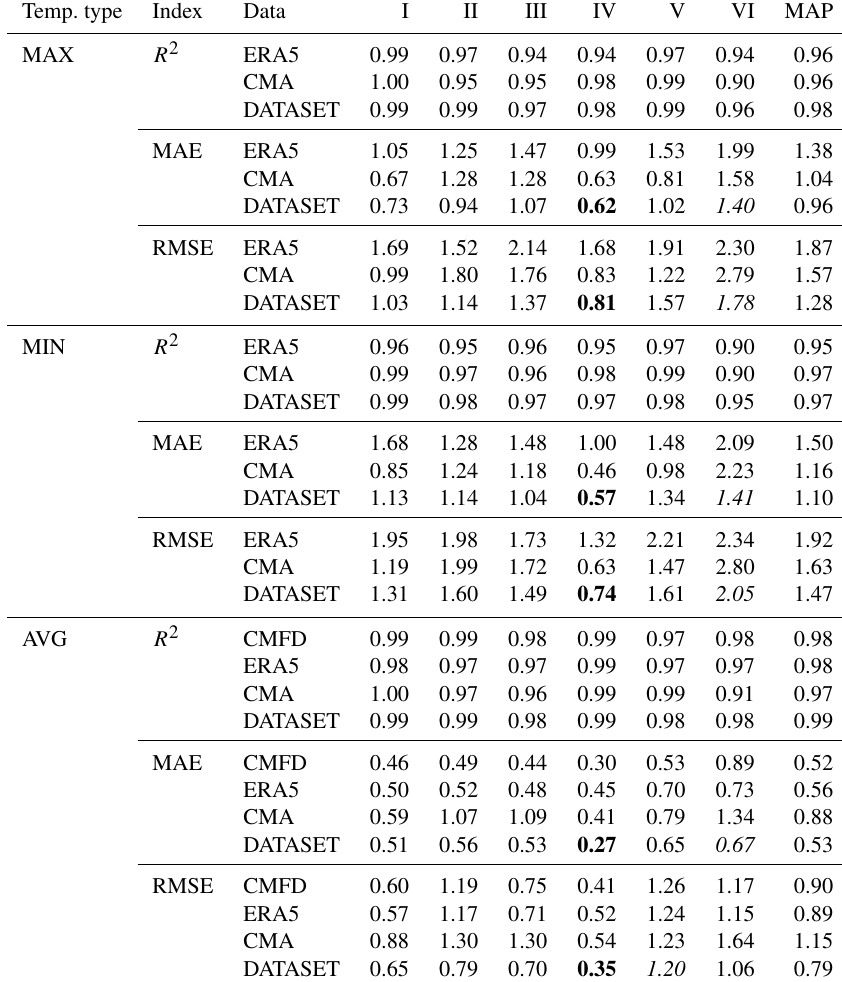
Table 1. Cross-validation results of this product and other datasets. Values in bold indicate study areas with the highest precision, and values in italics indicate the lowest